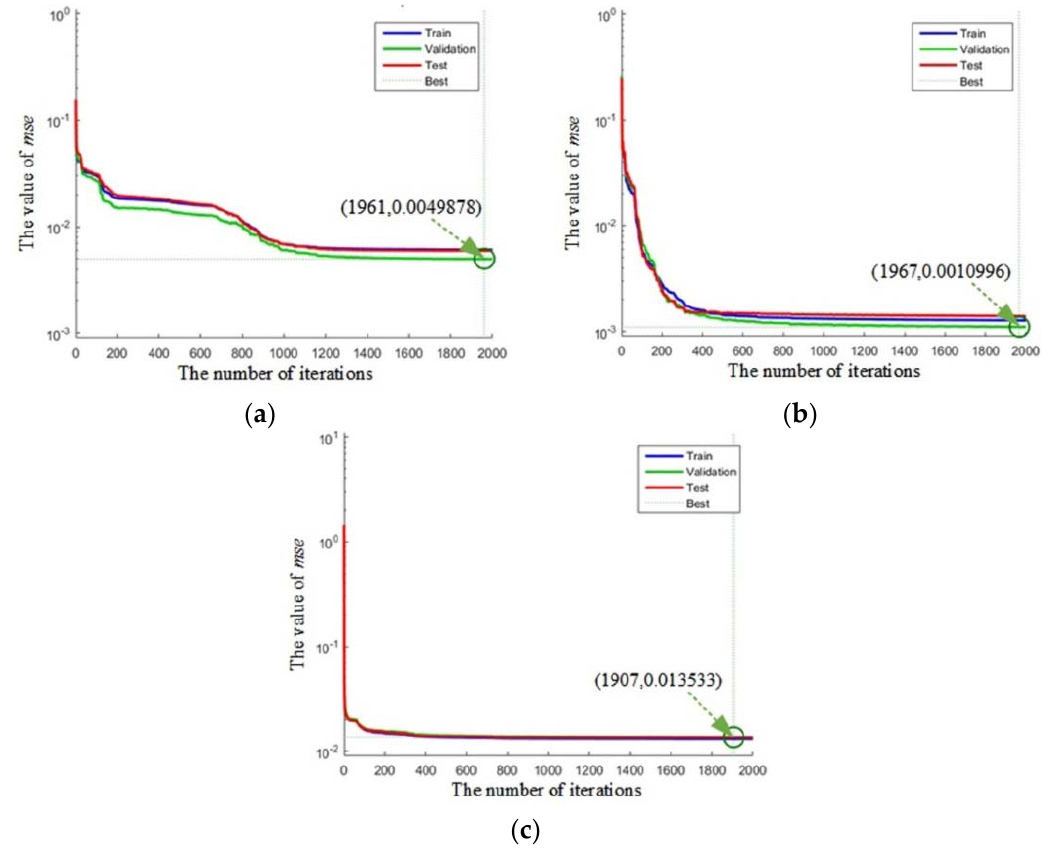
Figure 15. The values of mean square error ( mse ) for the linear neural network: ( a ) the result for aggressive driving type; ( b ) the result for general driving type; ( c ) the result for steady driving type.